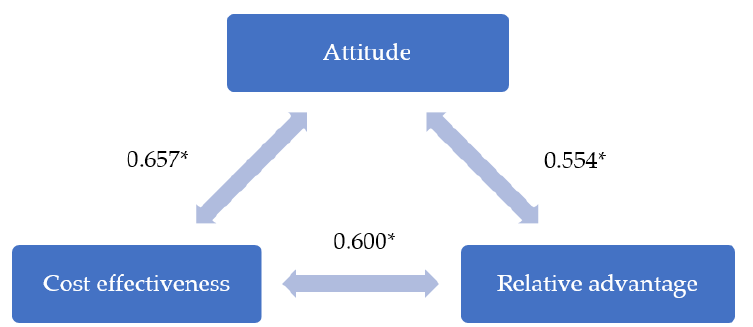
Figure 6. Relationship between the variables. * Correlation is significant at the 0.01 level (2-tailed).